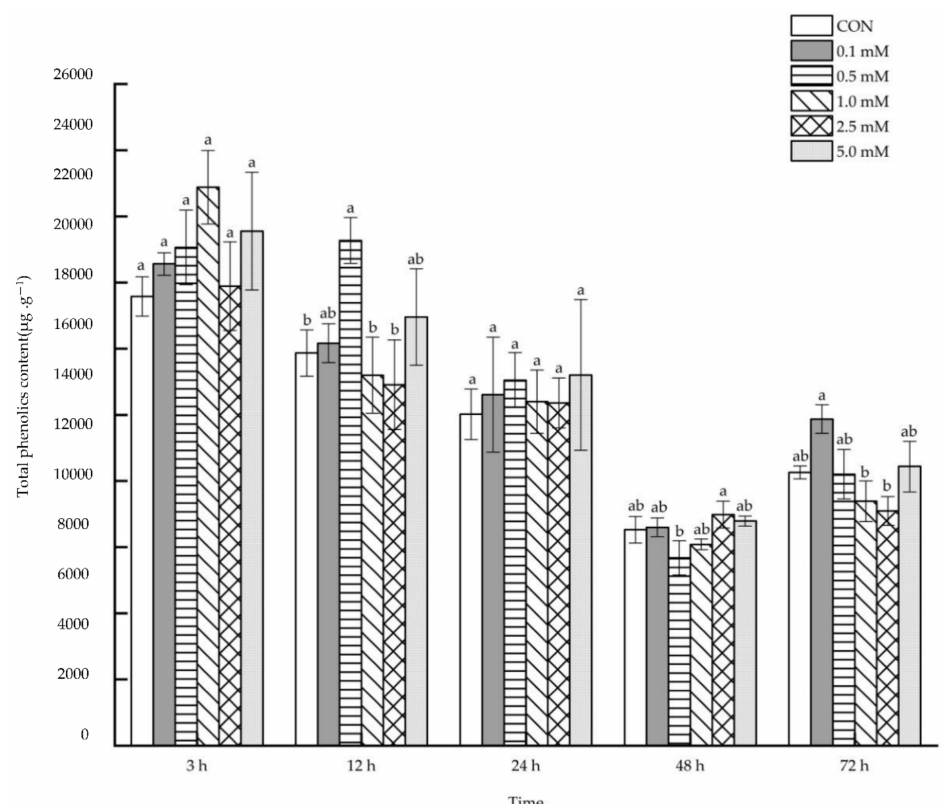
Figure 2. The direct effect of the SA concentration and post-treatment time on the total phenolics content in leaves following exogenous foliar application. The data are presented as mean ± standard errors. The significance of data was determined by the Duncan method. The difference between different letters at the same time reached significant levels of